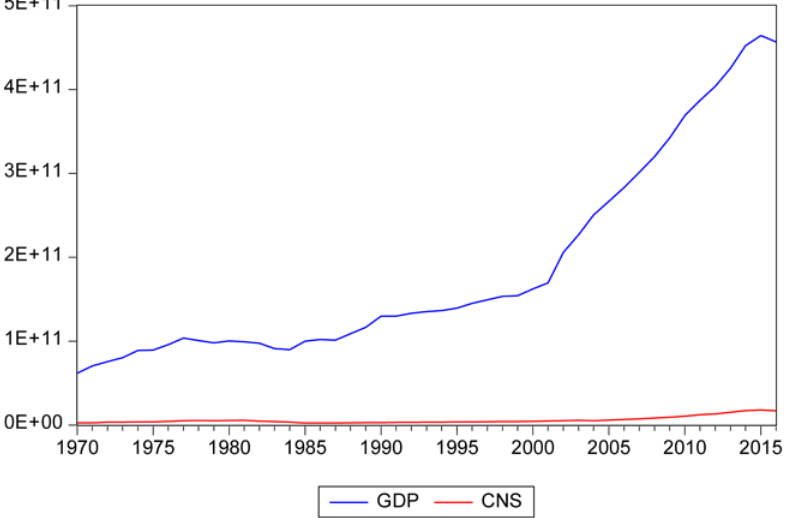
Figure 1 Line graph of Gross Domestic Product (GDP) and construction sector